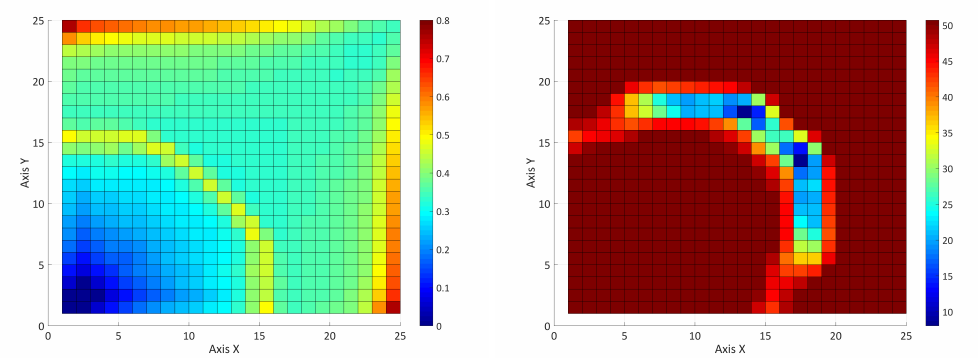
Figure 13. Oil saturation in a P+S scheme after 1000 days (separated— left ) and IFT [ mN / m ] after 1000 days in a P+S (overlapped— right ), considering adsorption and the presence of salt in the aqueous